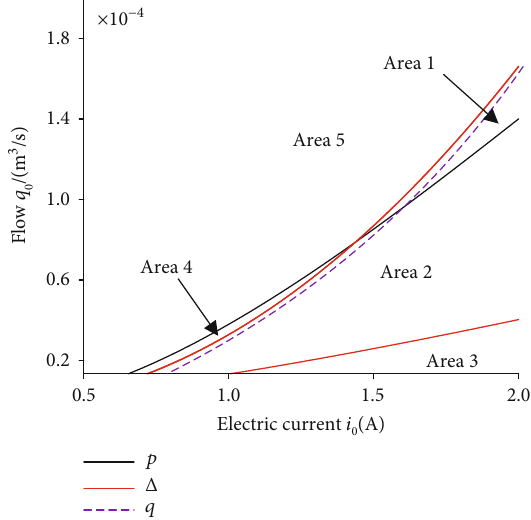
Figure 10: Positive and negative boundary of p , q , and △